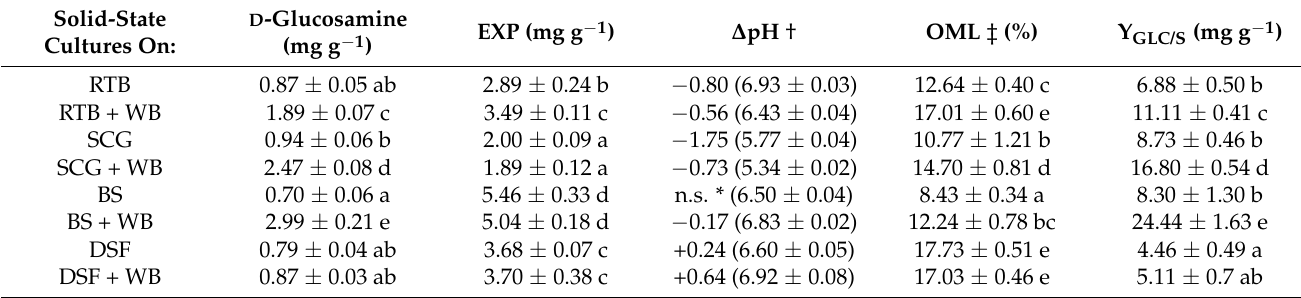
Table 2. D -glucosamine and extracellular protein (EXP) contents, pH changes, organic matter losses (OML) and yield of fungal biomass per unit of organic matter consumed (Y GLC/S ) in 14-day-old A. olivimuriae solid-state cultures carried out on residual thistle biomass (RTB), spent coffee grounds (SCG), barley straw (BS) and solid fraction of digestate (SFD) in the presence and in the absence of wheat bran (WB). Data are mean ± standard deviation of 4 replicates. Multiple pair-wise comparisons were made with Tukey’s test, and identical letters denote that column means were not statistically different ( p > 0.05).